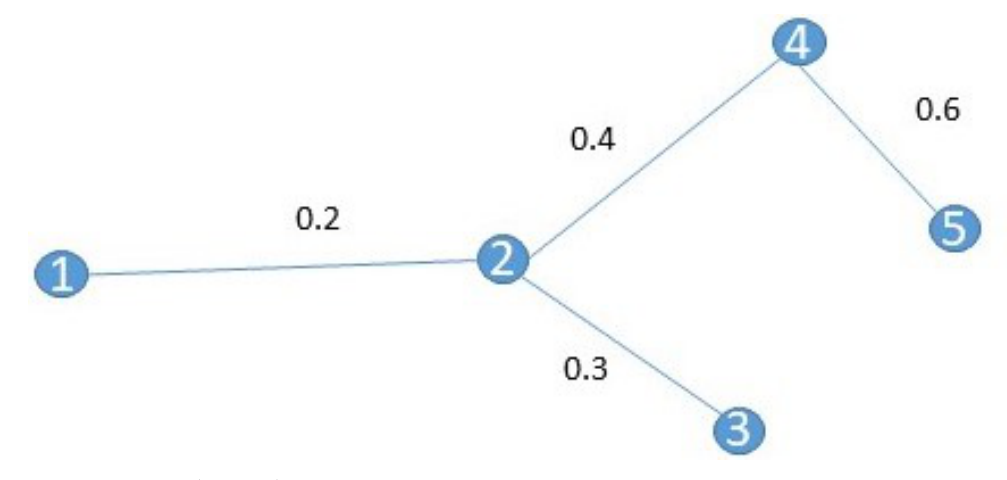
Figure 6. A simpler graph G 2 .